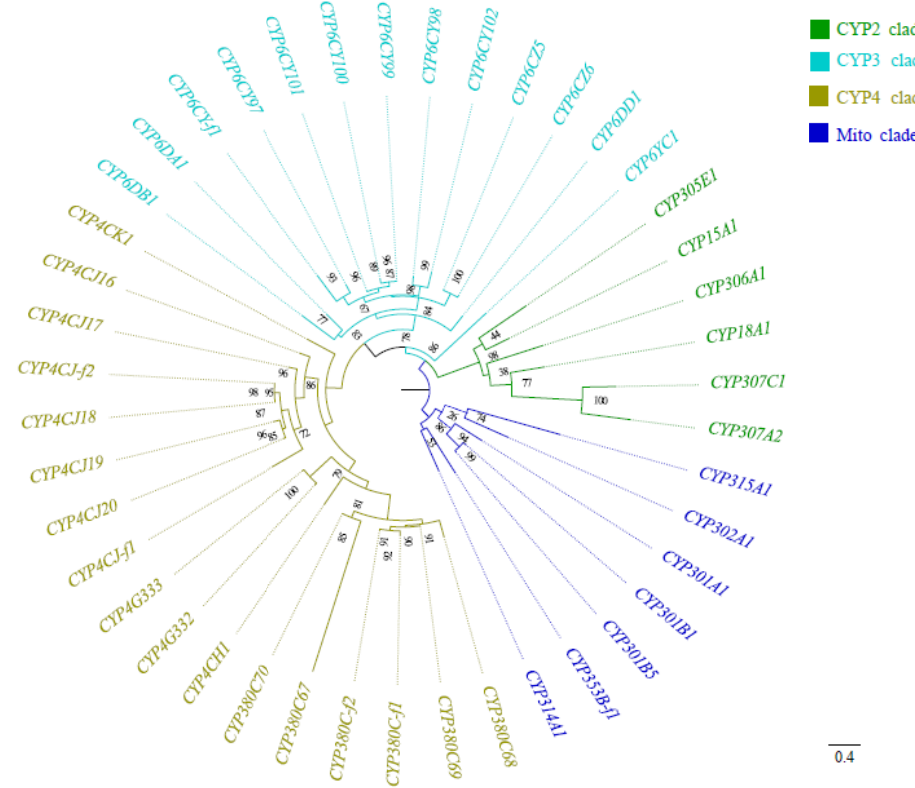
Figure 2. Phylogenetic analysis of P450 genes in Pseudoregma bambucicola . The tree was constructed with the maximum likelihood (ML) method using PhyloSuite. Bootstrap support values are indicated by numbers on nodes of phylogenetic tree. The clusters were highlighted in color to indicate different CYP clans. The letter “f” in the CYP name indicated that the P450 gene was a fragment. We produced a high-quality map based on the P. bambucicola genome and located 43 P450 genes on 6 chromosomes/linkage groups (LGs) (Figure 3). In total, 22 of the 43 P450 genes were tandemly arranged into 5 clusters of at least 3 P450 genes. P450 genes are usu- ally arranged in tandem, and this arrangement marks a P450 duplication event. The map reveals that the P. bambucicola P450 genes are unevenly distributed across the genome. For example, 20 P450 genes were located on chromosome 6. Chromosome 5 contains eight P450 genes. Similar numbers of genes were found on chromosomes 1, 3, and 4, which contained five, five, and four P450 genes, respectively. However, chromosome 2 only con- tained two P450 genes (Figure 3).